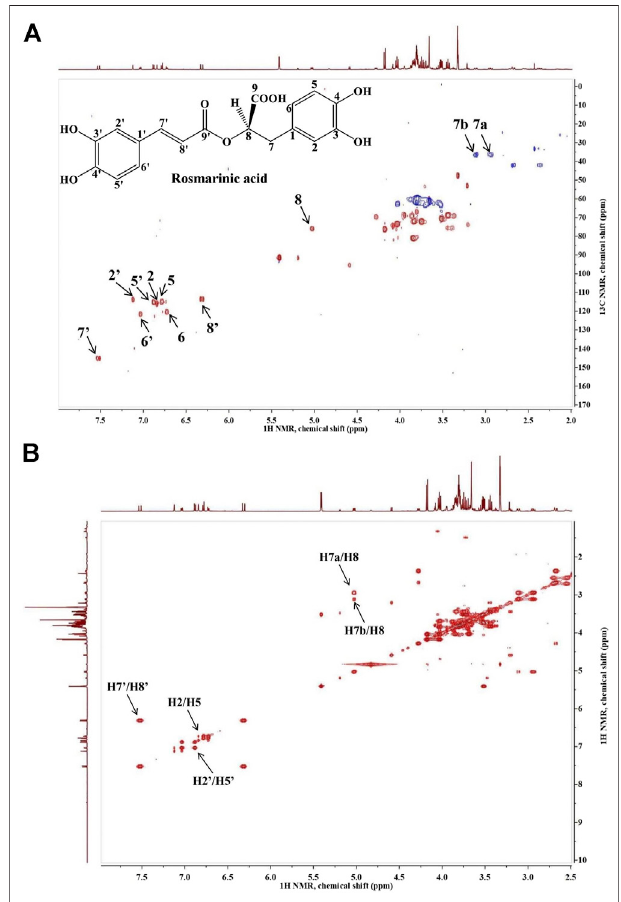
FIGURE 1 | Heteronuclear single quantum coherence spectroscopy ( 1 H- 13 C HSQC (A) ) and homonuclear correlation spectroscopy ( 1 H – 1 H COSY (B) ) spectra of Lavandula angustifolia extract and the characteristic signals of rosmarinic acid.